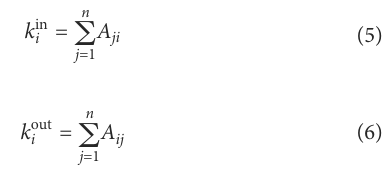
FIGURE 3 Tidal level validation at Beijin station (A) and Shangchuan Island station (B)